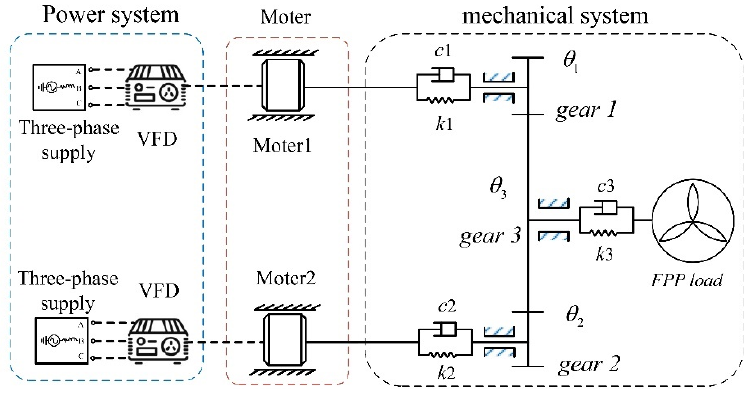
Figure 2. Model of the ship’s two-engine and one-shaft propulsion system.